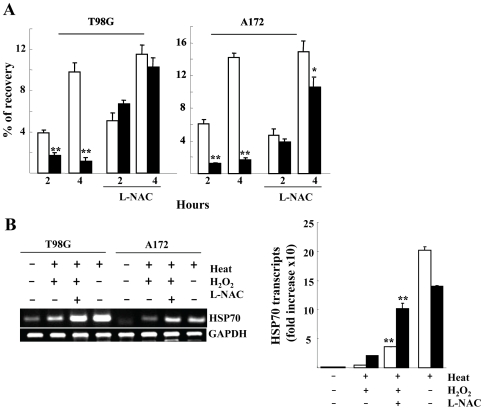
Recovery of protein folding activity.
A) Refolding activity. Cells were transiently co-transfected with the pGRE/RL-TK reporter genes, treated with 5 mM dexamethazone for 10-12 h, exposed to heat (44°c for 20 min) with (closed) or without (open bars) 0.25 mM H2O2 pretreatment, incubated for 2 to 4 h and luciferase activity was measured. Cells were also incubated with 5 mM L-NAC for 30 min prior to 0.25 mM H2O2 pretreatment. *, P<0.05, **, P<0.01 compared with H2O2-untreated cells. B) HSP70 transcripts. Total RNA was harvested from cells treated as indicated and HSP70 transcripts were evaluated by RT-PCR (left). HSP70 transcripts were determined by real-time PCR and normalized to GAPDH levels (right panel). **, P<0.01 compared with heat/H2O2-treated cells. Columns display the mean ± S.D. of data from three separate experiments.